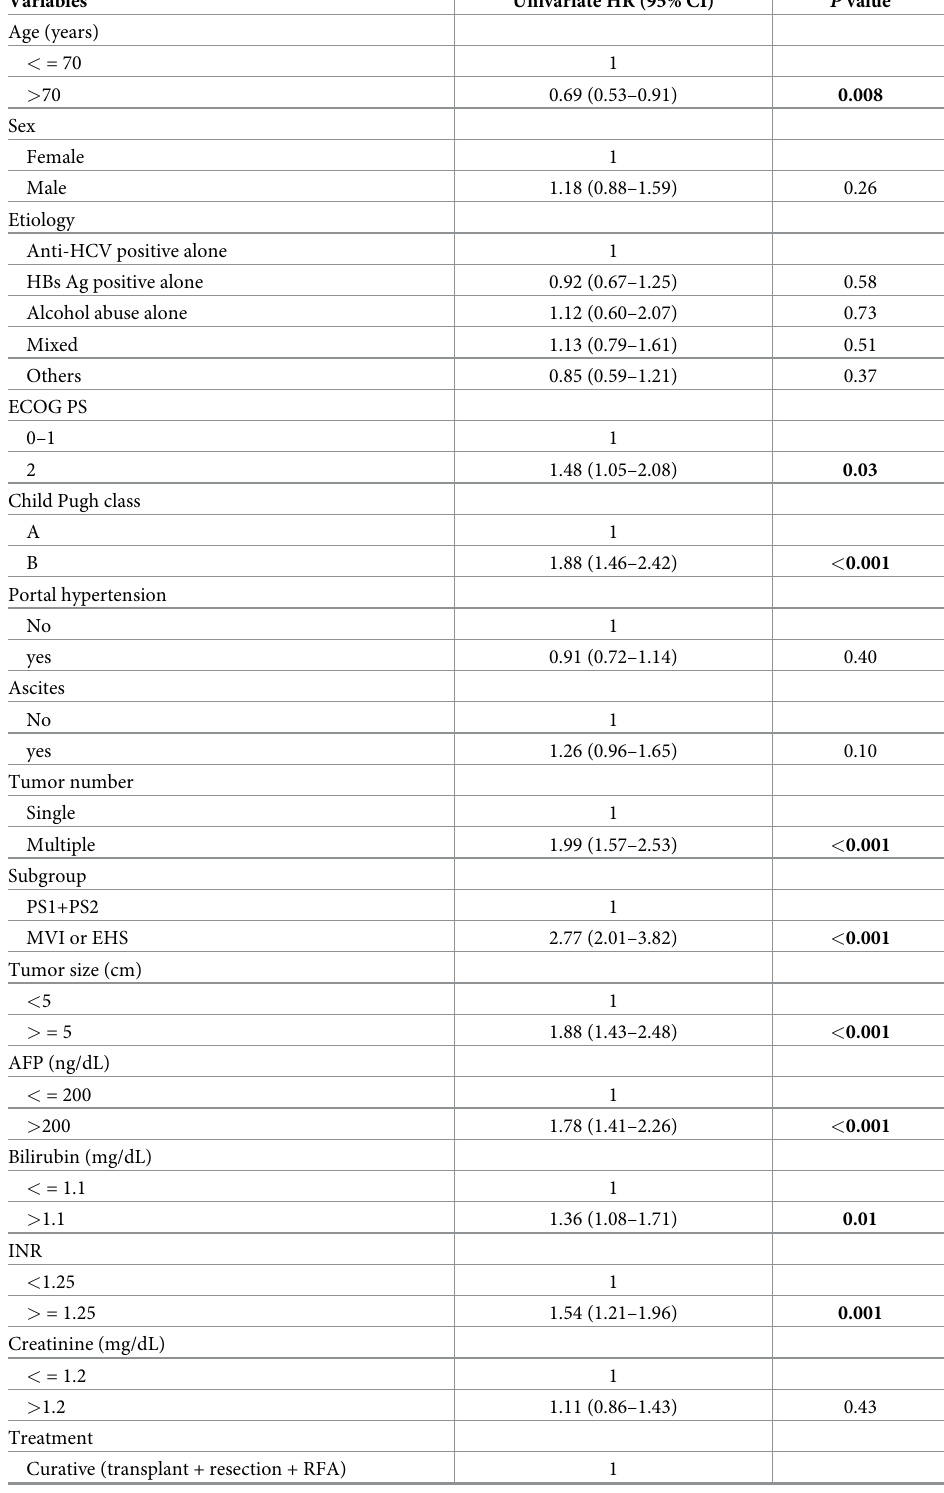
Table 3. Risk factors for mortality in patients with advanced HCC (BCLC C